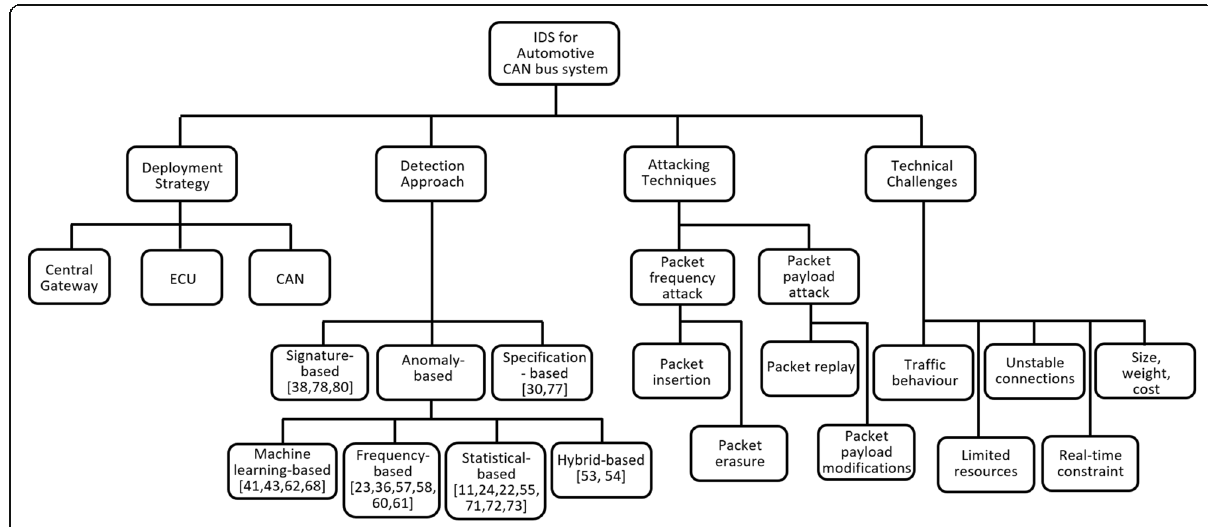
Fig. 3 The IDS taxonomy for CAN bus network in automotive domain is inspired by four core aspects covered in this review. The four